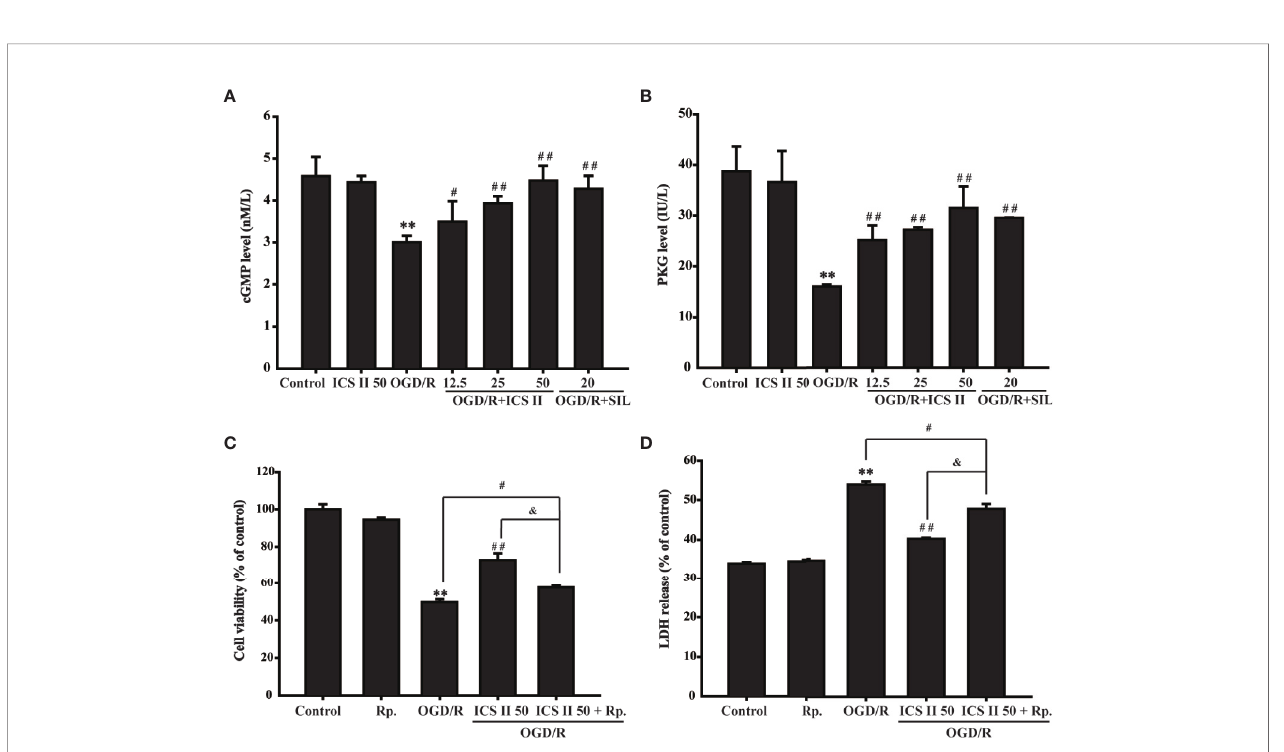
FIGURE 4 | ICS II enhanced cGMP level and PKG activity (A) cGMP protein expression was detected by ELISA kit. (B) PKG activity was determined by PKG activity kit. PKG-speci fi c inhibitor Rp-8-Br-cGMP (Rp.) abolished the bene fi cial effects of ICS II. (C) Cell viability tested by MTT assay. (D) LDH release was detected using an LDH release assay kit. ** P < 0.01 versus control group; # P < 0.05, ## P < 0.01 versus OGD/R group, & P < 0.01 versus OGD/R+ ICS II 50